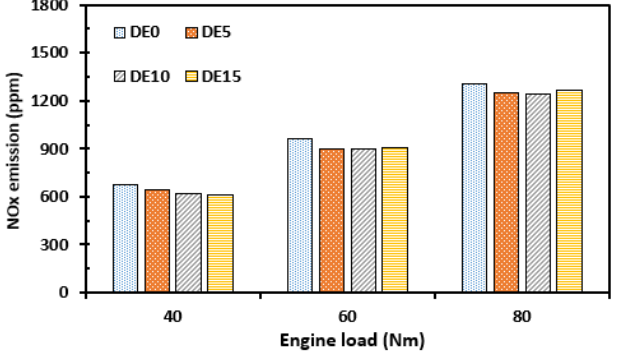
Figure 9. NOx emissions.